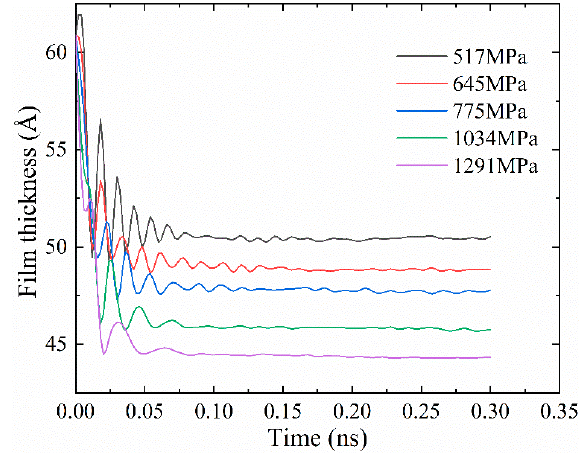
Figure 5. The lubrication film thickness under different pressure loads ( h 0 = 6nm).